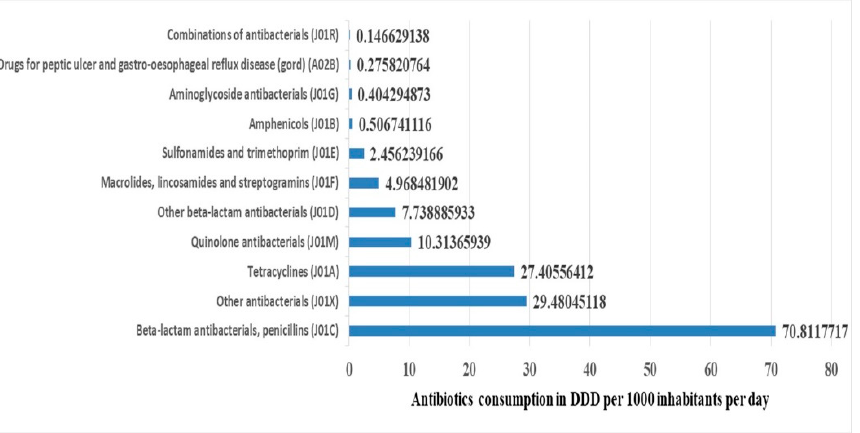
Figure 2. Contribution of each class (level 3 ATC classification) of antibiotics utilized in Tanzania from 2010 to 2016.